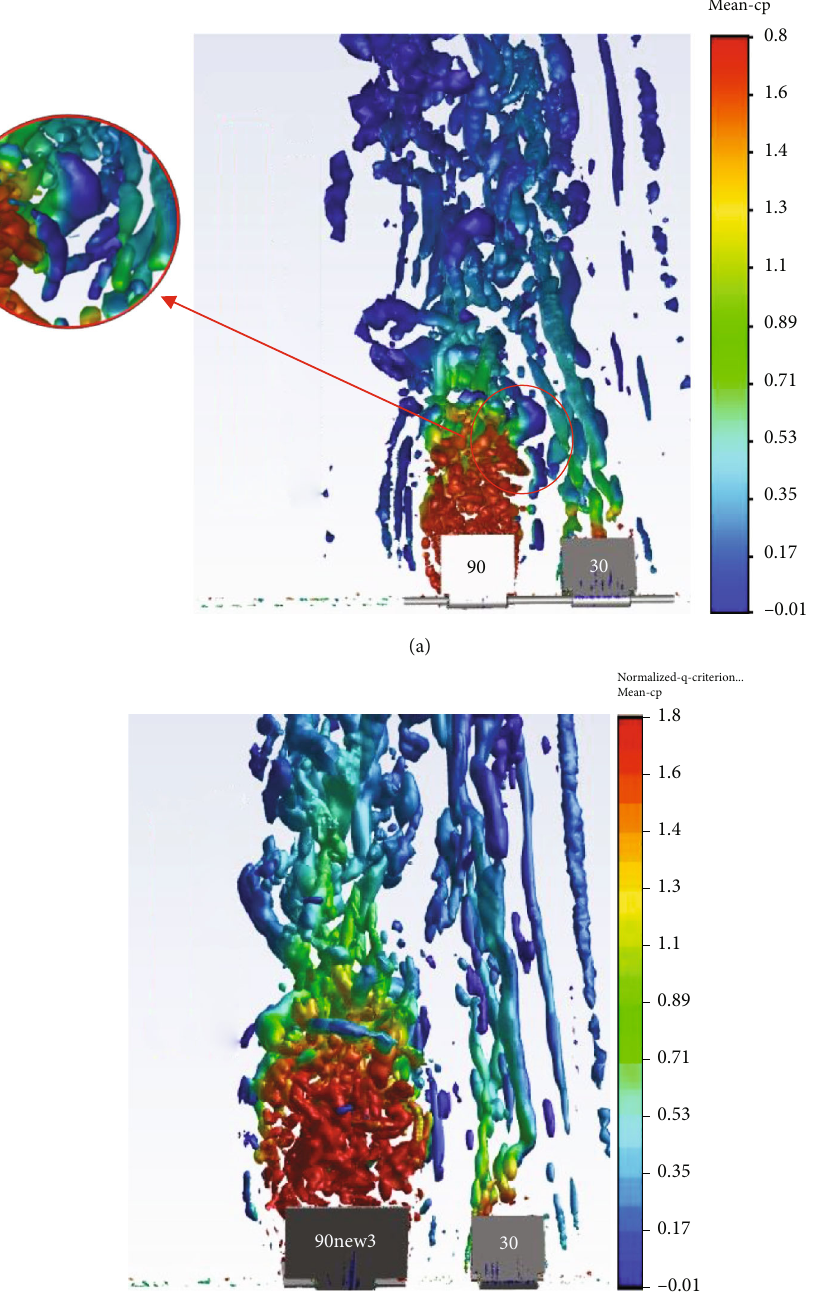
Figure 11: Comparison of combined fl ow structures for 90-standard and 90new3 dual arrangements with 30 ° wedge at the same CW in the form of normalized Q − criterion = 0 : 1 isosurface colored by mean cp